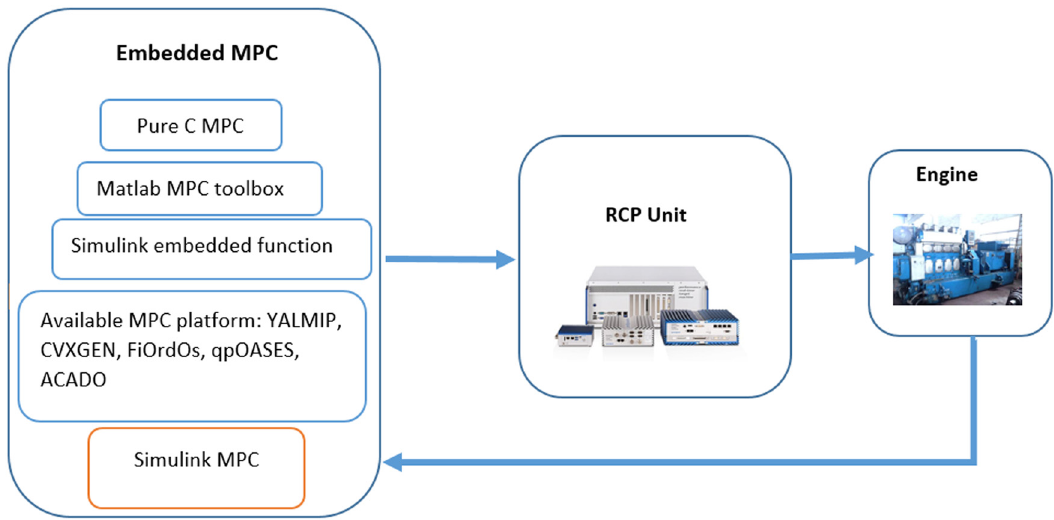
Figure 6: MPC for RCP implementation framework.